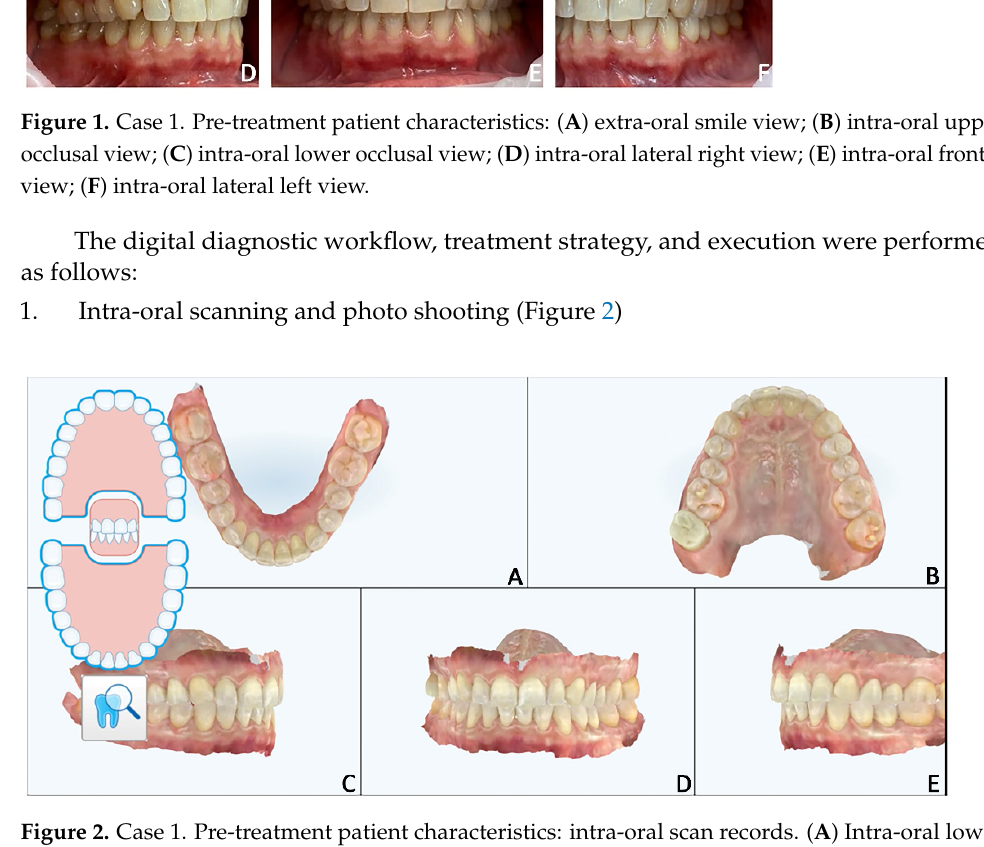
Figure 2. Case 1. Pre-treatment patient characteristics: intra-oral scan records. ( A ) Intra-oral lower occlusal view; ( B ) intra-oral upper occlusal view; ( C ) intra-oral lateral right view; ( D ) intra-oral frontal view; ( E ) intra-oral lateral left view.